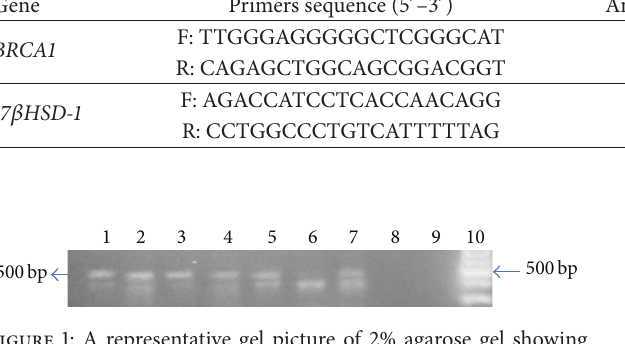
Figure 1: A representative gel picture of 2% agarose gel showing BRCA1 methylation status of two cases. Lanes 1, 2, 3, 4, 5, and 7: the presence of (500bp) band indicates methylation of BRCA1 promoter inthesespecimens.Lanes6and8:absenceof(500 bp)bandindicates the absence of methylation of BRCA1 promoter in these specimens.